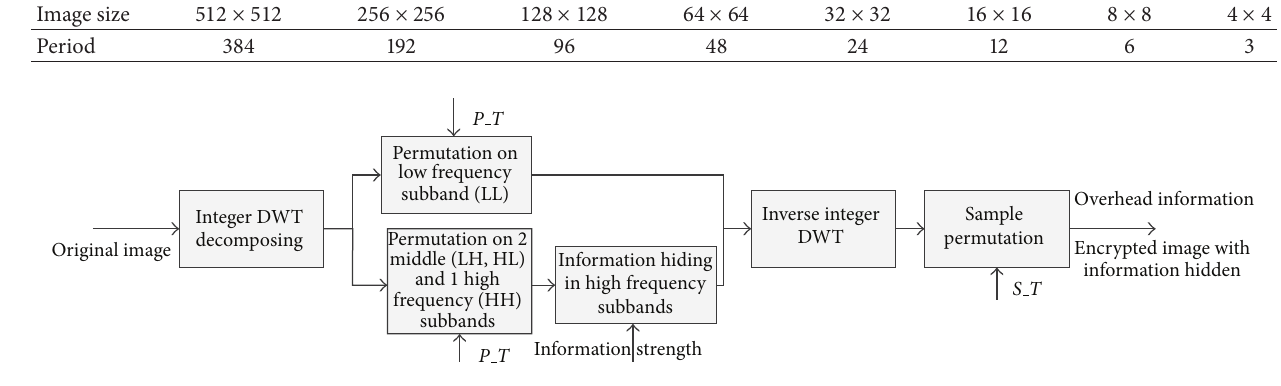
Figure 2: Data hiding and image encryption.